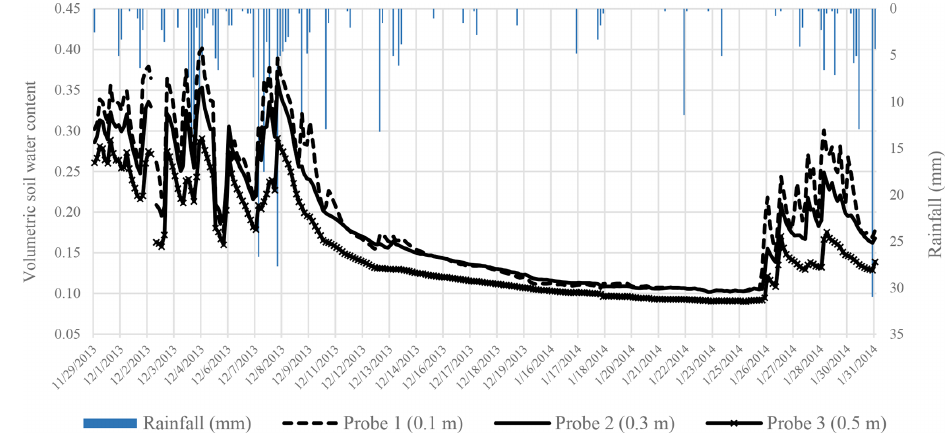
Figure 9. Hourly soil volumetric water content and the hourly rainfall at site 2 at New